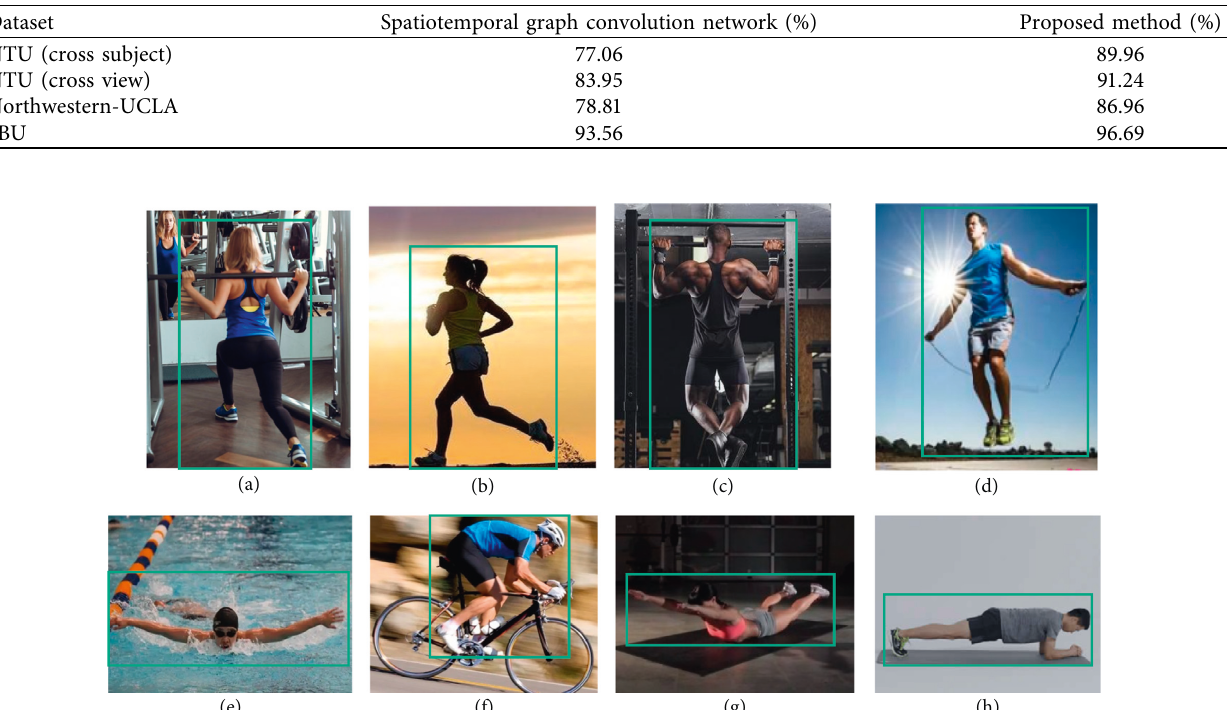
Figure 9: Sample frames of each motion in the UCF motion dataset. (a) Barbell training. (b) Running. (c) Pull-ups. (d) Jumping rope. (e) Swimming. (f) Cycling. (g) Flying swallow. (h) Plank